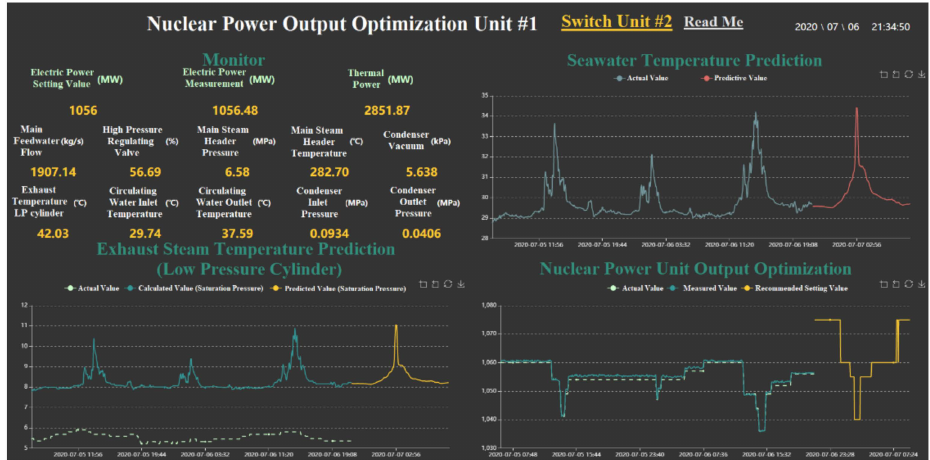
Figure 3. Monitoring and Forecast Program of Nuclear Power